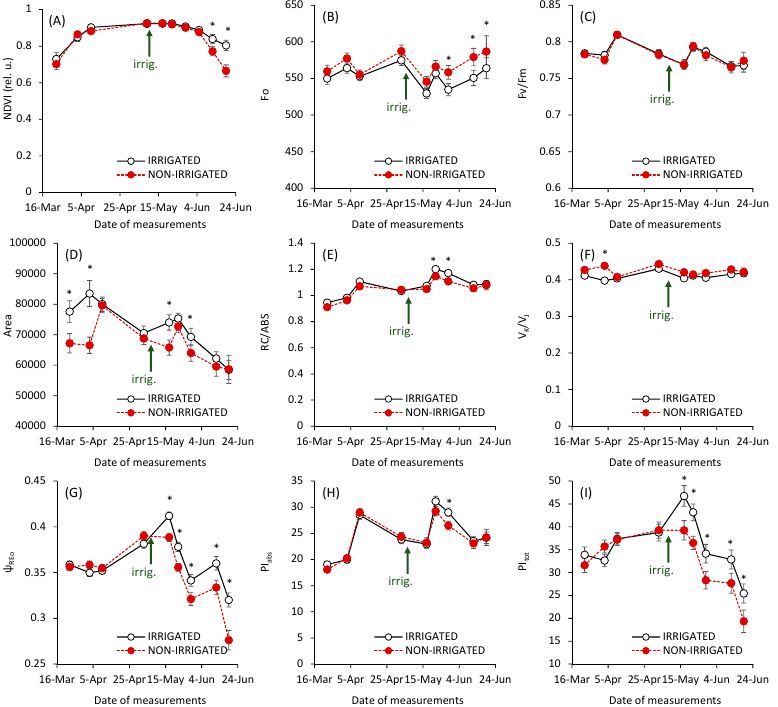
Figure 3. Parameters based on spectral reflectance and chlorophyll fluorescence records in wheat grown in field in two variants differing in water supply: ( A ) Normalized Difference Vegetation Index (NDVI); ( B ) Minimum fluorescence from dark-adapted leaf (F 0 ); ( C ) Maximum quantum yield of primary photochemistry of photosystem II (F v / Fm ); ( D ) Proportion of Q B -non-reducing PSII center (Area); ( E ) The number of reaction centers per absorbed light unit (RC/ABS); ( F ) Relative variable fluorescence in K-step (V K /V J ); ( G ) Probability with which the electron trapped by PSII will reach the secondary quinone electron acceptor Q B ( ψ ETo ); ( H ) Performance index on absorption basis (PI ABS ); and ( I ) Total performance index (PI TOT ). Days of the season are characterized on the x -axis; the period of initiation of irrigation is indicated. The points represent the mean values ± standard error of 25 genotypes, 10 individuals per genotype ( n = 250). An asterisk indicates significant differences between non-irrigated and irrigated variants (Tukey HSD post hoc test, p <